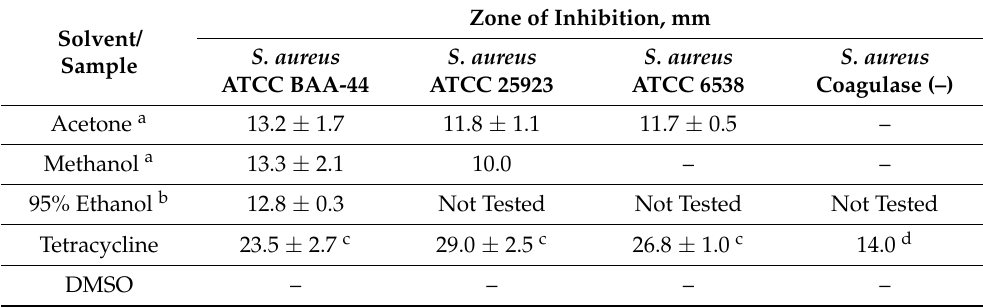
Table 1. Antibacterial screening of C. cajan seed extracts against S. aureus